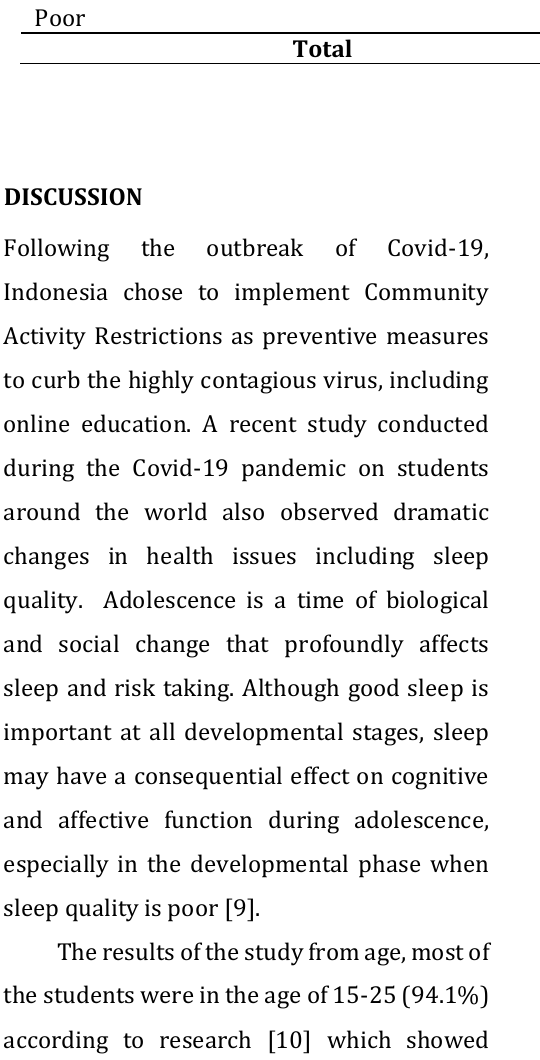
Table 2 Sleep of Quality Student of Nursing in Bali Good